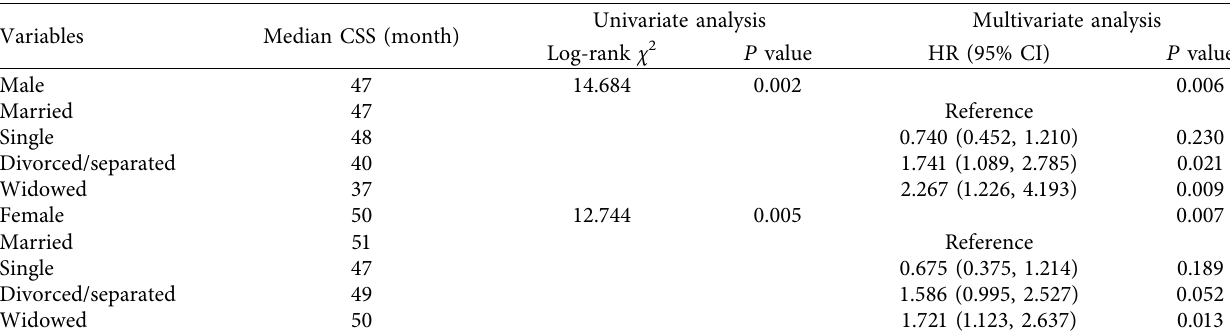
Table 5: Univariate and multivariate analysis for evaluating the influence of marital status on CCS according to gender.